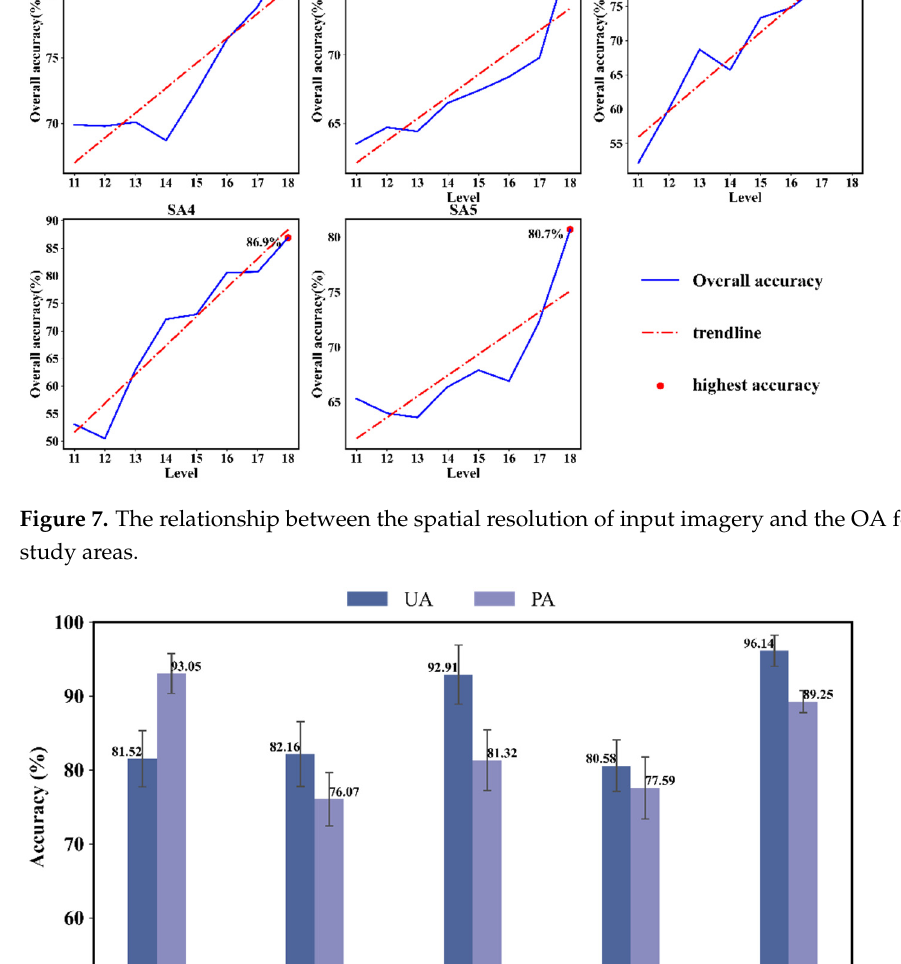
Figure 8. User’s and producer’s accuracy (UA and PA) for grape identification using spatial features.